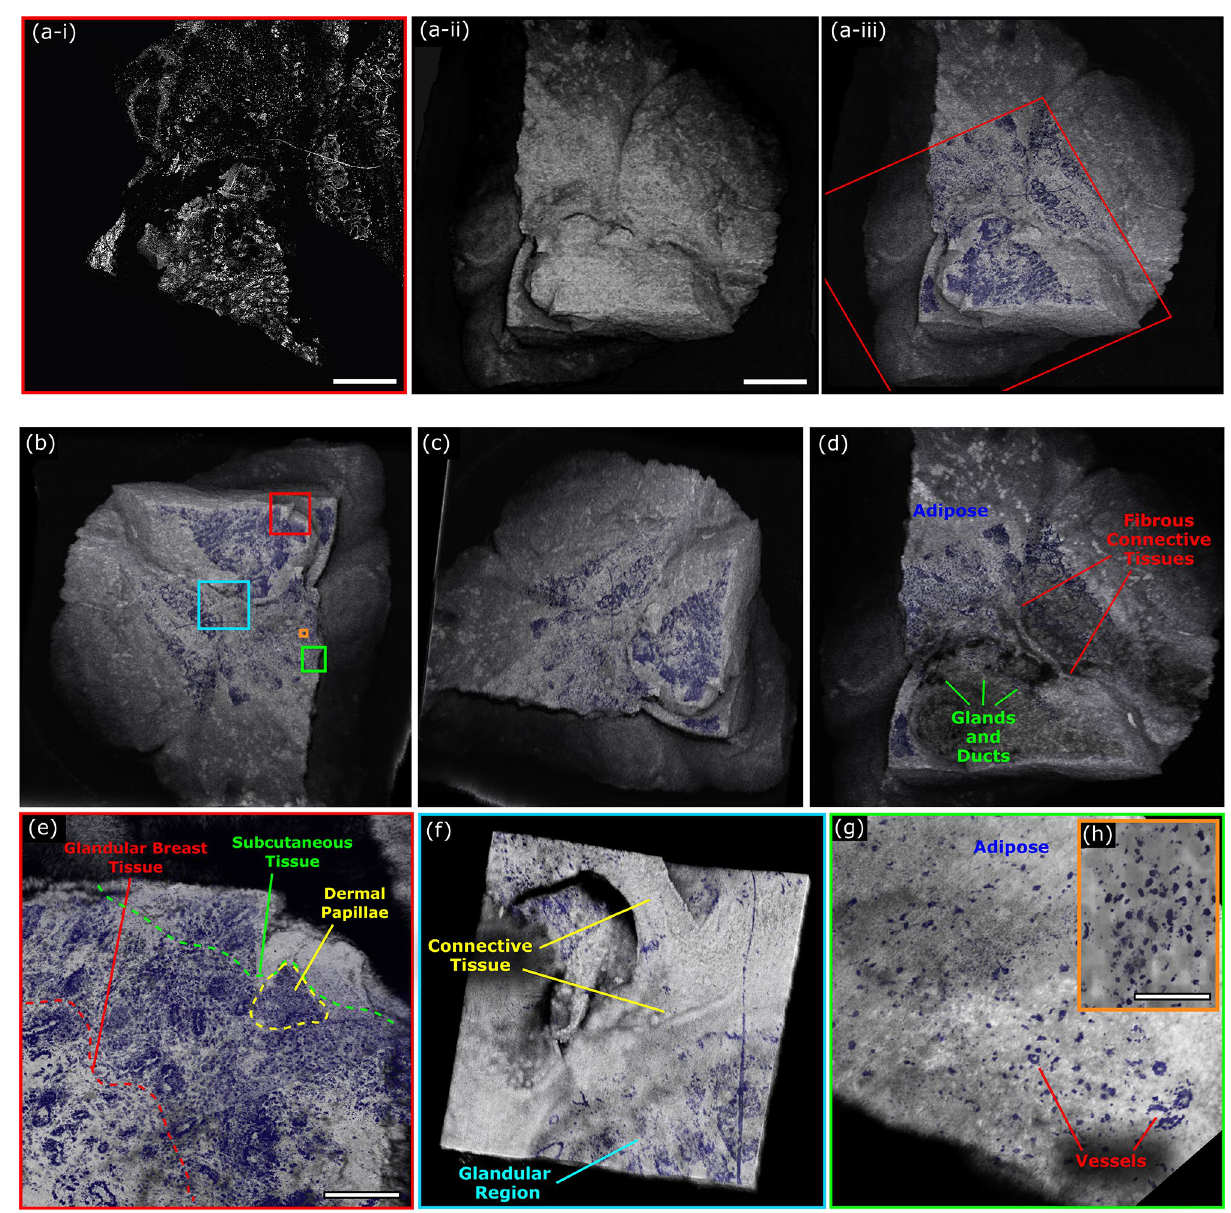
Figure 8. Combined PARS and OCT imaging of unprocessed excised Rattus mammary tumor tissue. ( a ) ( i ) PARS image of resected Rattus mammary tumor. Scale Bar: 1 mm. ( ii ) OCT (0.14 NA) image of entire section of resected Rattus mammary tumor tissues. Scale Bar: 1.25 mm. ( iii ) Merged PARS and OCT image of resected Rattus mammary tumor. Red box outlines limits of PARS image. ( b , c ) Different angles of 3D representation of merged PARS and OCT images of excised Rattus mammary tumor tissue. ( d ) Vertical subsection of PARS and OCT image showing subsurface tumor tissue morphology and nuclear visualizations. ( e – h ) Merged PARS and OCT (0.4 NA) image of resected Rattus mammary tumor. ( e ) Scale Bar: 250 µm. ( h ). Scale Bar: 100